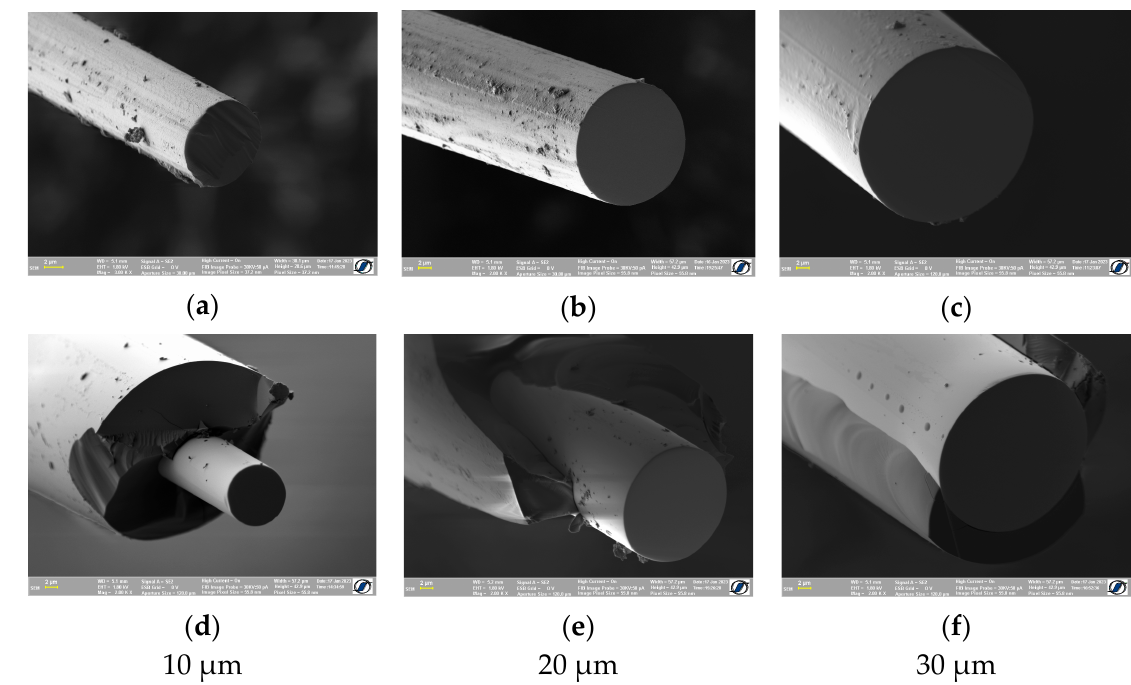
Figure 1. Scanning Electron Microscopy (SEM) images of cold-drawn ( a – c ) and glass-coated ( d – f ) Fe 73.5 Si 13.5 B 9 Cu 1 Nb 3 microwires having 10, 20, and 30 µm metallic core diameters.